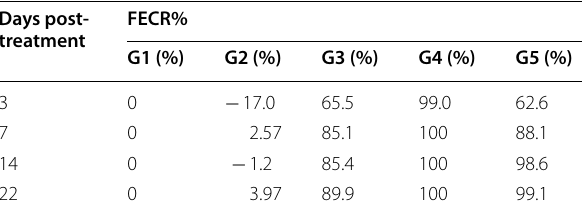
Table 3 The FECR% recorded in G1 (uninfected untreated), G2 (infected untreated), G3 ( A. herba-alba ), G4 ( B. aegyptiaca ) versus G5 (albendazole) at different days post‑treatment Days post‑